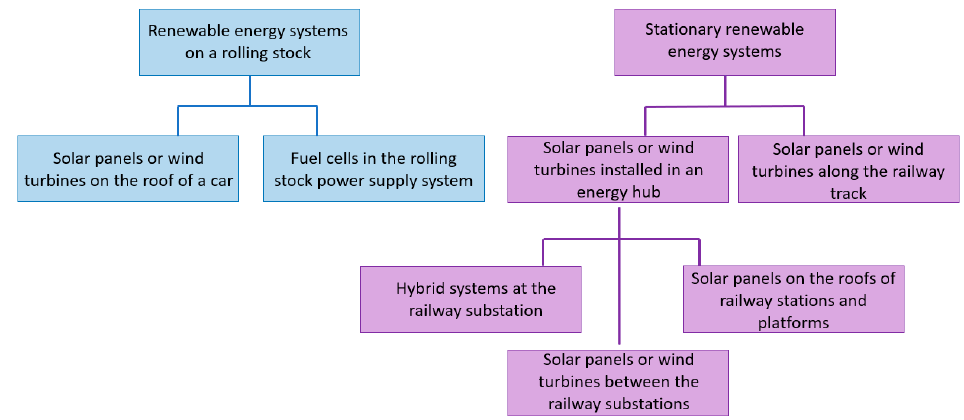
Figure 1. RE sources classification for the railway transport electrification systems.